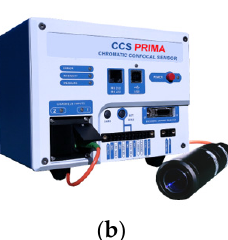
Figure 9. The fabricated quick-change fixture. ( a ) Unlocking state; ( b ) locking state; ( c ) the final installation configuration.